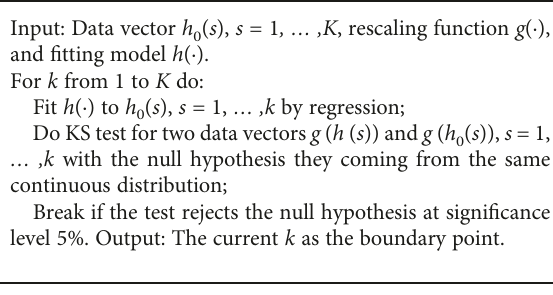
Algorithm 2: Boundary point detection algorithm for general